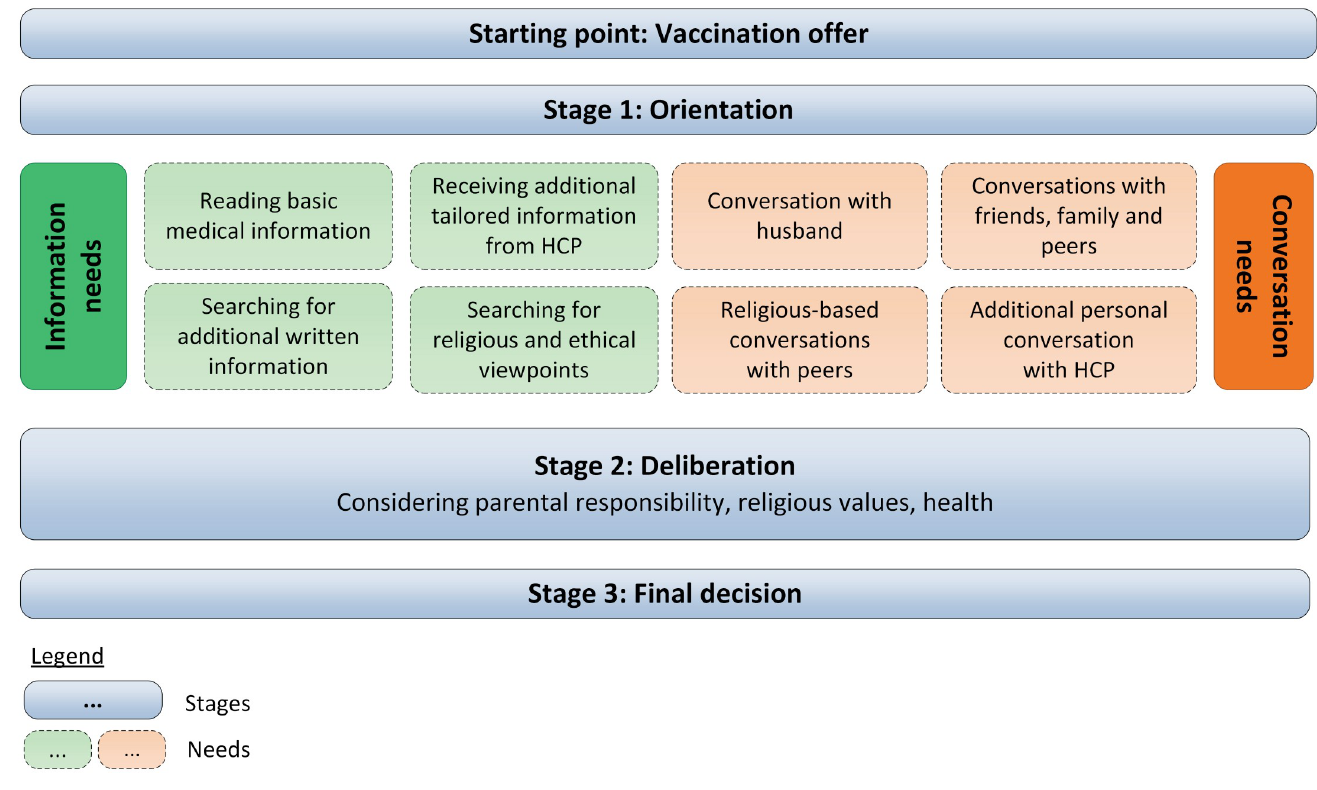
Fig 2. Framework of decision-making process on maternal pertussis vaccination among orthodox Protestant women.